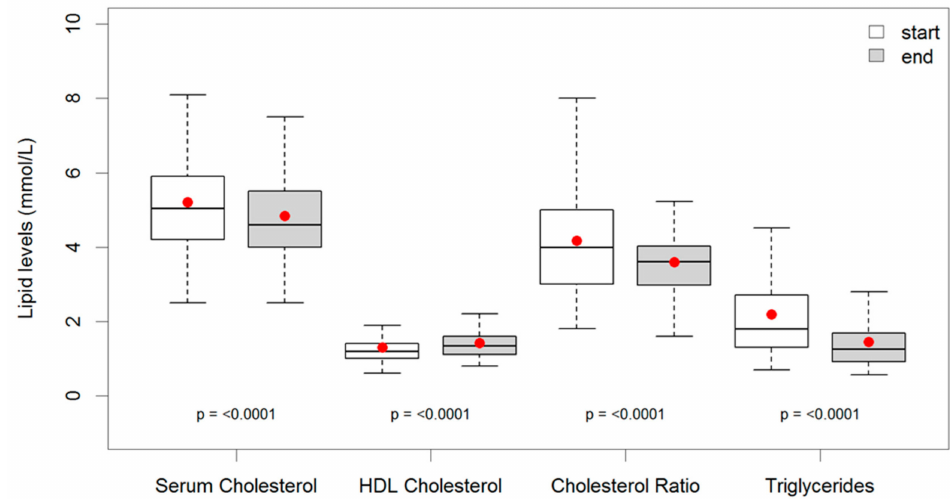
Figure 4. Box and whisker plots of the lipid profile results before and after an average of 24 months on a low carb diet. (Serum cholesterol is total cholesterol, triglyceride is a fasting sample).